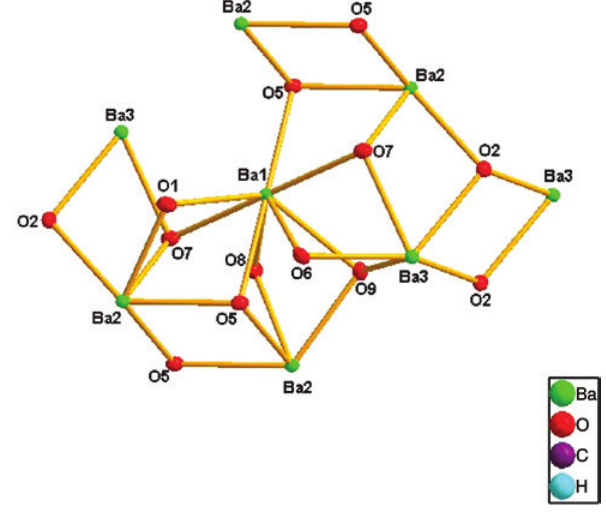
Figure 4: Phthalate coordination geometry of PDTP. Figure 5: The Ba